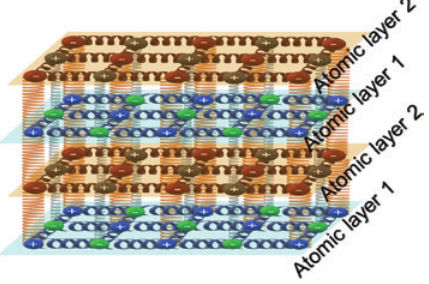
Figure 9: Atomic-level designer PhP materials. atomic layer materials. The in-plane IR-active phonons emanate